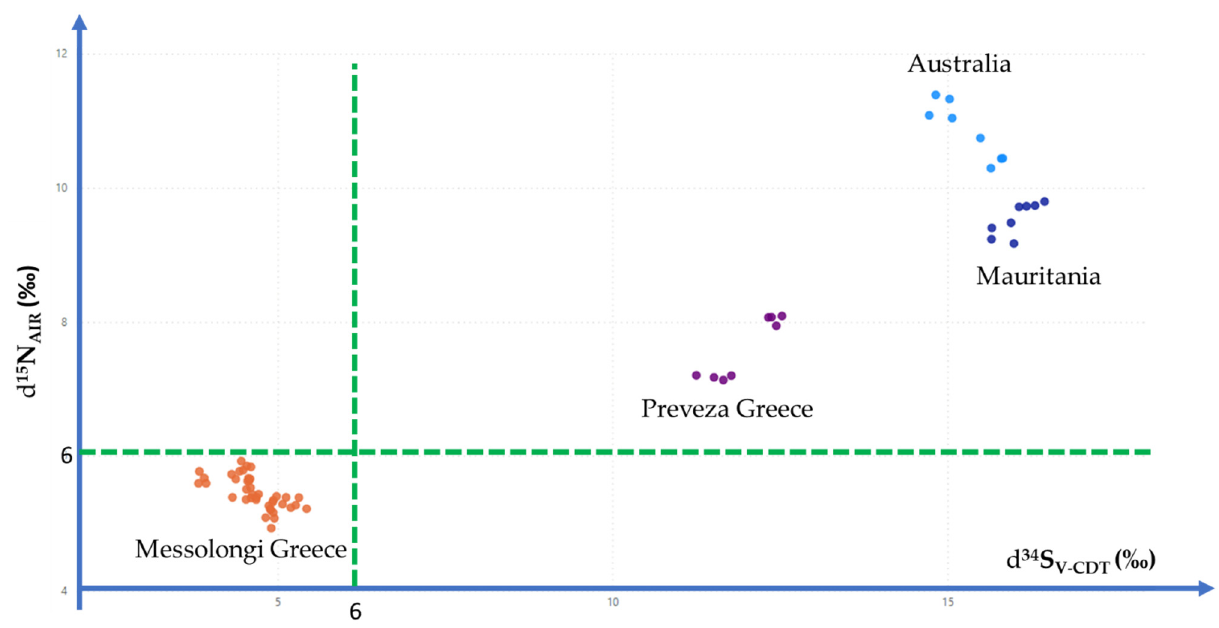
Figure 5. Decision criterion to determine geographic origin of the Greek Bottarga (Fish—Roe) Registered PDO ‘Avgotaracho Messolongi ou’.